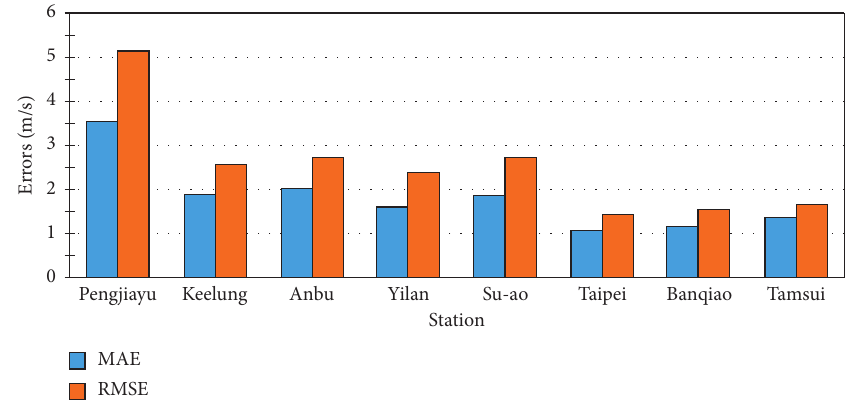
Figure 6: Simulation performance in terms of prediction errors.